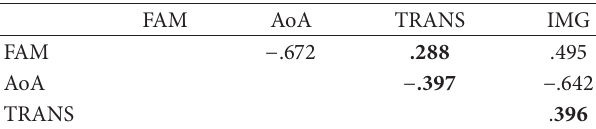
Table 2: Pearson correlations between the measures of the linguistic